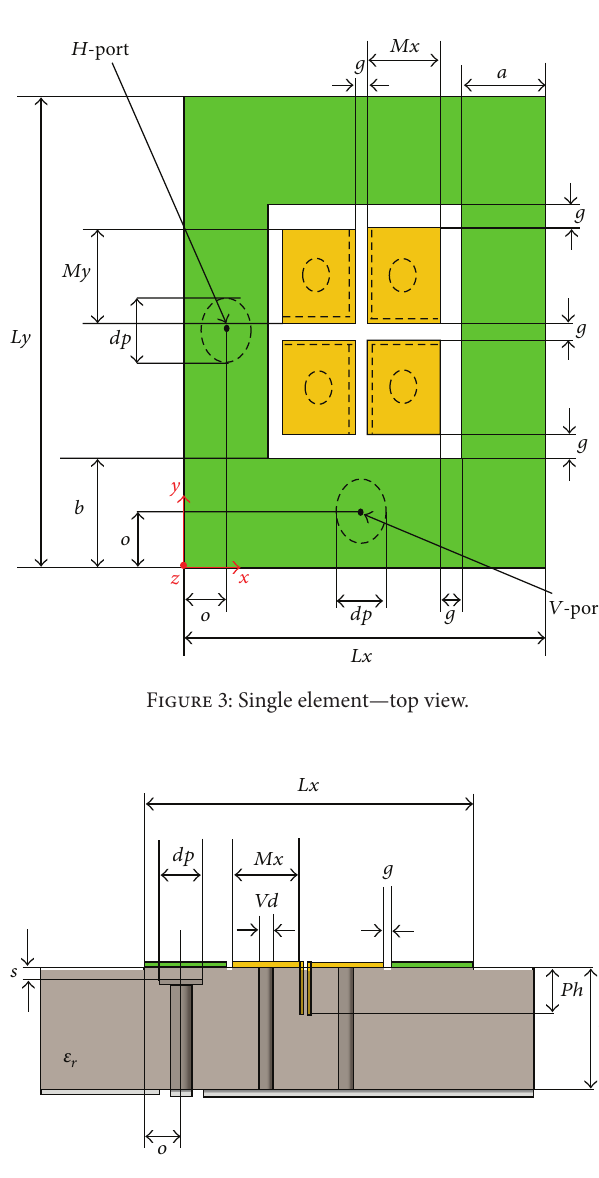
Figure 4: Single element—cross view (V-port not